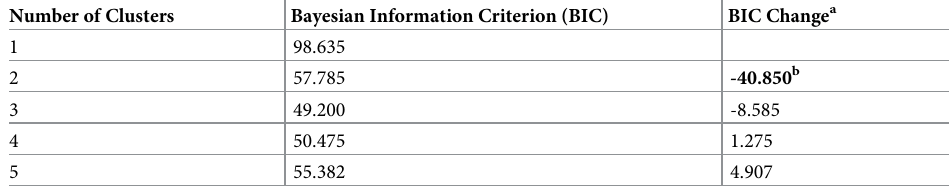
Table 3. Auto clustering information of rented car